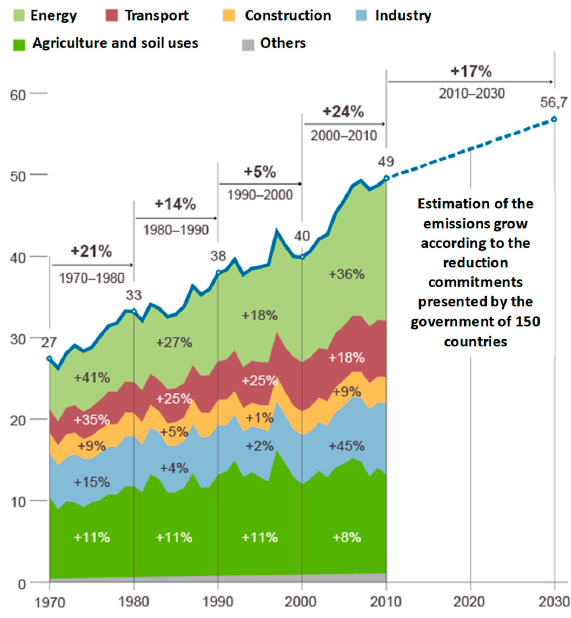
Figure 2. World emissions of greenhouse gases (GHG) by sectors, in gigatons of CO 2 equivalent annually [2].